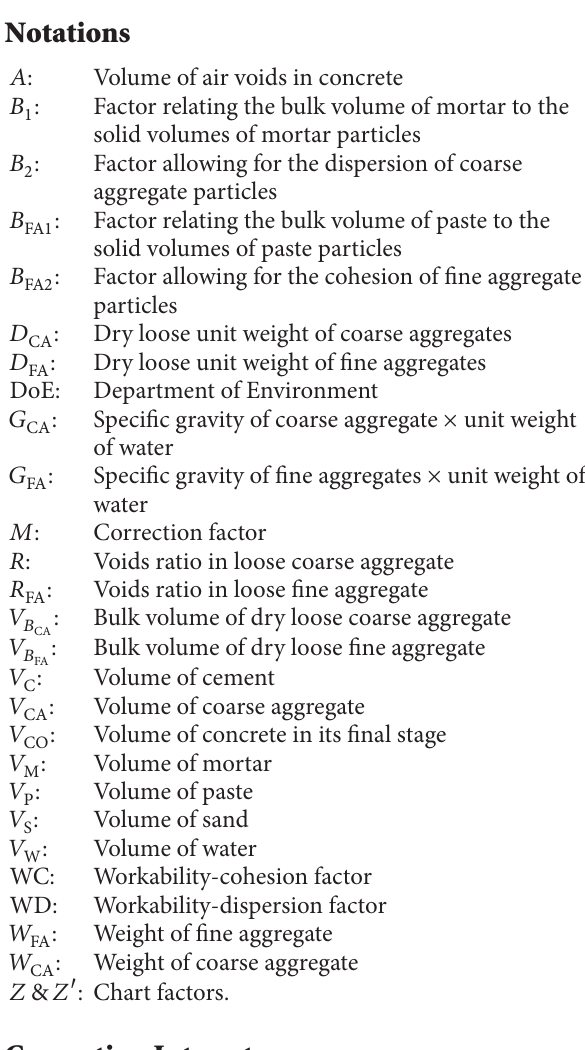
From Figure 4 using c / w value, medium workability plot,